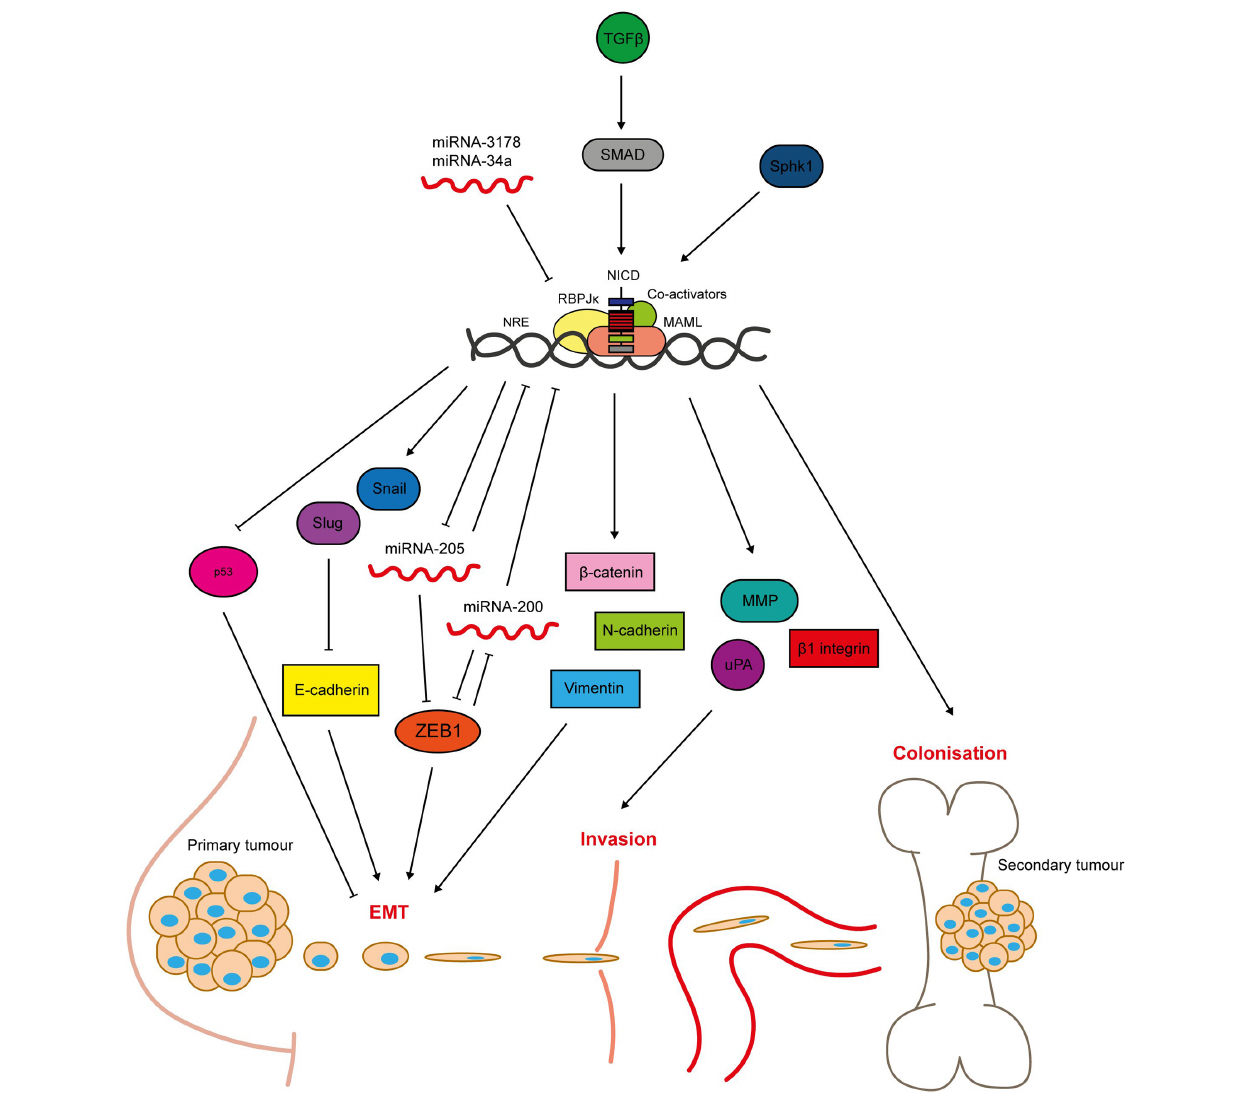
FIGURE 5 | Notch signalling regulates breast cancer cell metastasis. Notch-mediated metastasis is induced by factors such as TGF β and Sphk1 (Zavadil et al., 2004; Zhang et al., 2010; Sethi et al., 2011; Wang S. et al., 2018b). Notch activates key regulators of EMT including the transcriptional repressors Slug and Snail, that mediate loss of cell-cell contacts through inhibition of E-cadherin expression (Leong et al., 2007; Sahlgren et al., 2008; Zhang et al., 2010; Du et al., 2012; Shao et al., 2015; Kong et al., 2018). The mesenchymal markers ZEB1, β -catenin, N-cadherin and vimentin are upregulated by Notch signalling (Bolós et al., 2013; Lai et al., 2018). ZEB1 is activated through complex bi-directional signalling involving micro-RNAs (Brabletz et al., 2011). Micro-RNAs negatively regulate Notch signalling, and their loss is sufficient to induce EMT in breast epithelial cells (Du et al., 2012; Chao et al., 2014; Kong et al., 2018). Notch is also implicated in tissue invasion, as it upregulates matrix-degrading enzymes including MMP2 and 9 and urokinase-type plasminogen activator (uPA), as well as β 1-integrin (Shimizu et al., 2011; Lai et al., 2018). Anti-apoptotic Notch signalling (see Figure 4 ) enables the cells to survive in the blood stream and travel to secondary sites. Notch signalling between the cancer cells and cells in the bone microenvironment facilitates colonisation and growth at the metastatic site (Sethi et al.,